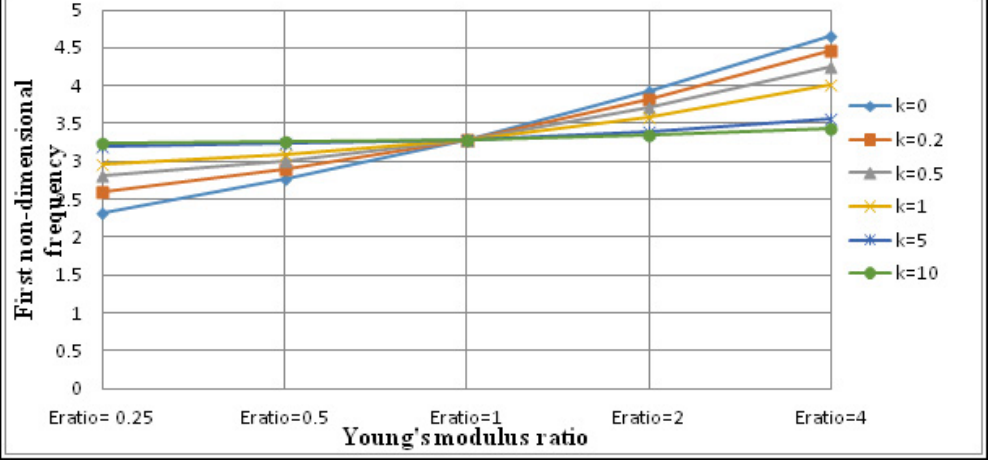
Figure 7: variation of the first non- dimensional frequency with Young's Modulus